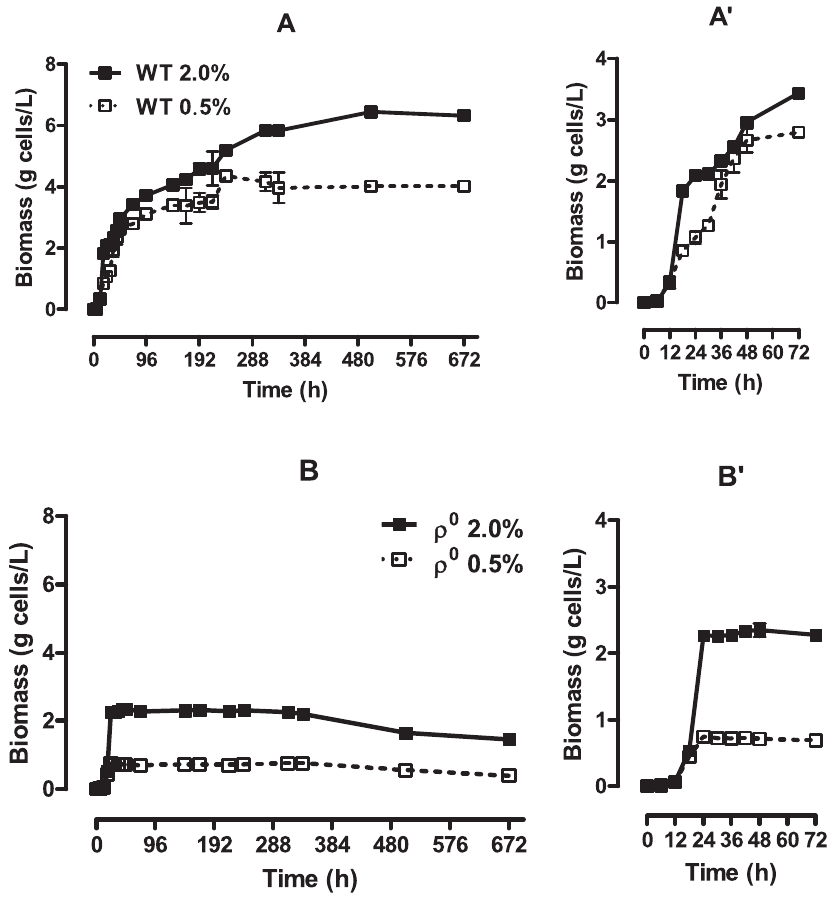
Figure 5. Biomass formation is altered by glucose levels and respiratory integrity. Biomass values during WT and r 0 S. cerevisiae (Panels A- A’ and B-B’, respectively) chronological aging were measured as described in Materials and Methods . Panels A’ and B’ show a reduced time scale of the exponential growth phase.